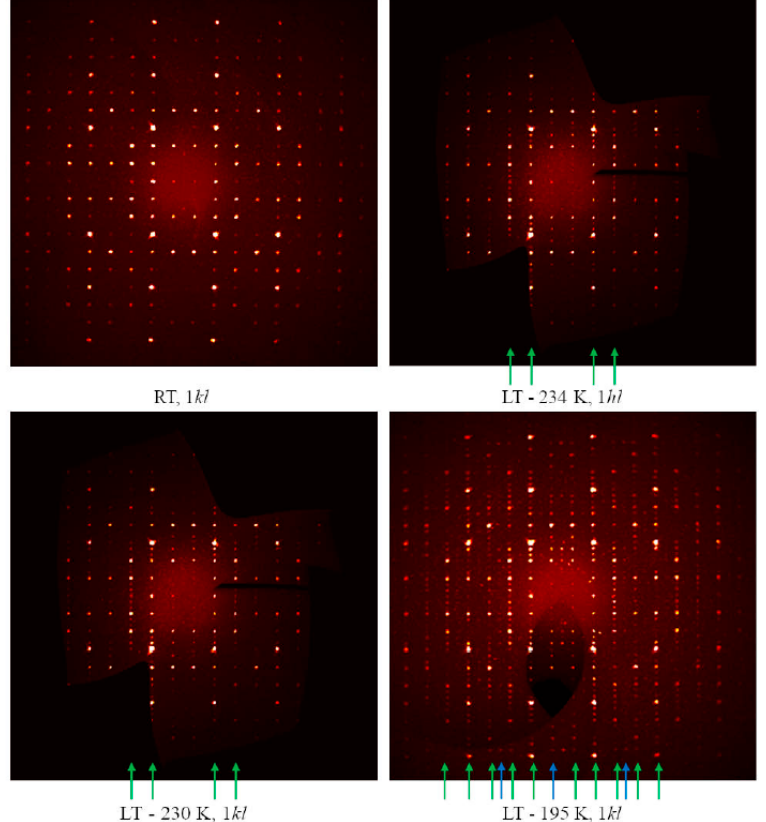
Figure 9. Reconstructed 1 kl zone intensity profiles for Cu 3 As obtained at different temperatures. The green arrows indicate the lines along which the peaks associated with the formation of the LT polymorph ( hP 72, a ′ ≈ a and c ′ ≈ 3 c ) appear. Blue arrows indicate a set of very weak super-reflections compatible with an even larger unit cell ( hP 144, a ′ ≈ 2 a and c ′ ≈ 3 c ). A total of 3490 frames were collected for the − 78 °C (195 K) dataset. The integration of the data using a trigonal unit cell yielded a total of 57,491 reflections to a maximum θ angle of 36.39° (0.60 Å resolution), of which 1568 were independent (average redundancy 37, com- pleteness = 99.8%, R int = 7.43%, R sig = 2.10%). The analysis of systematic absences per-